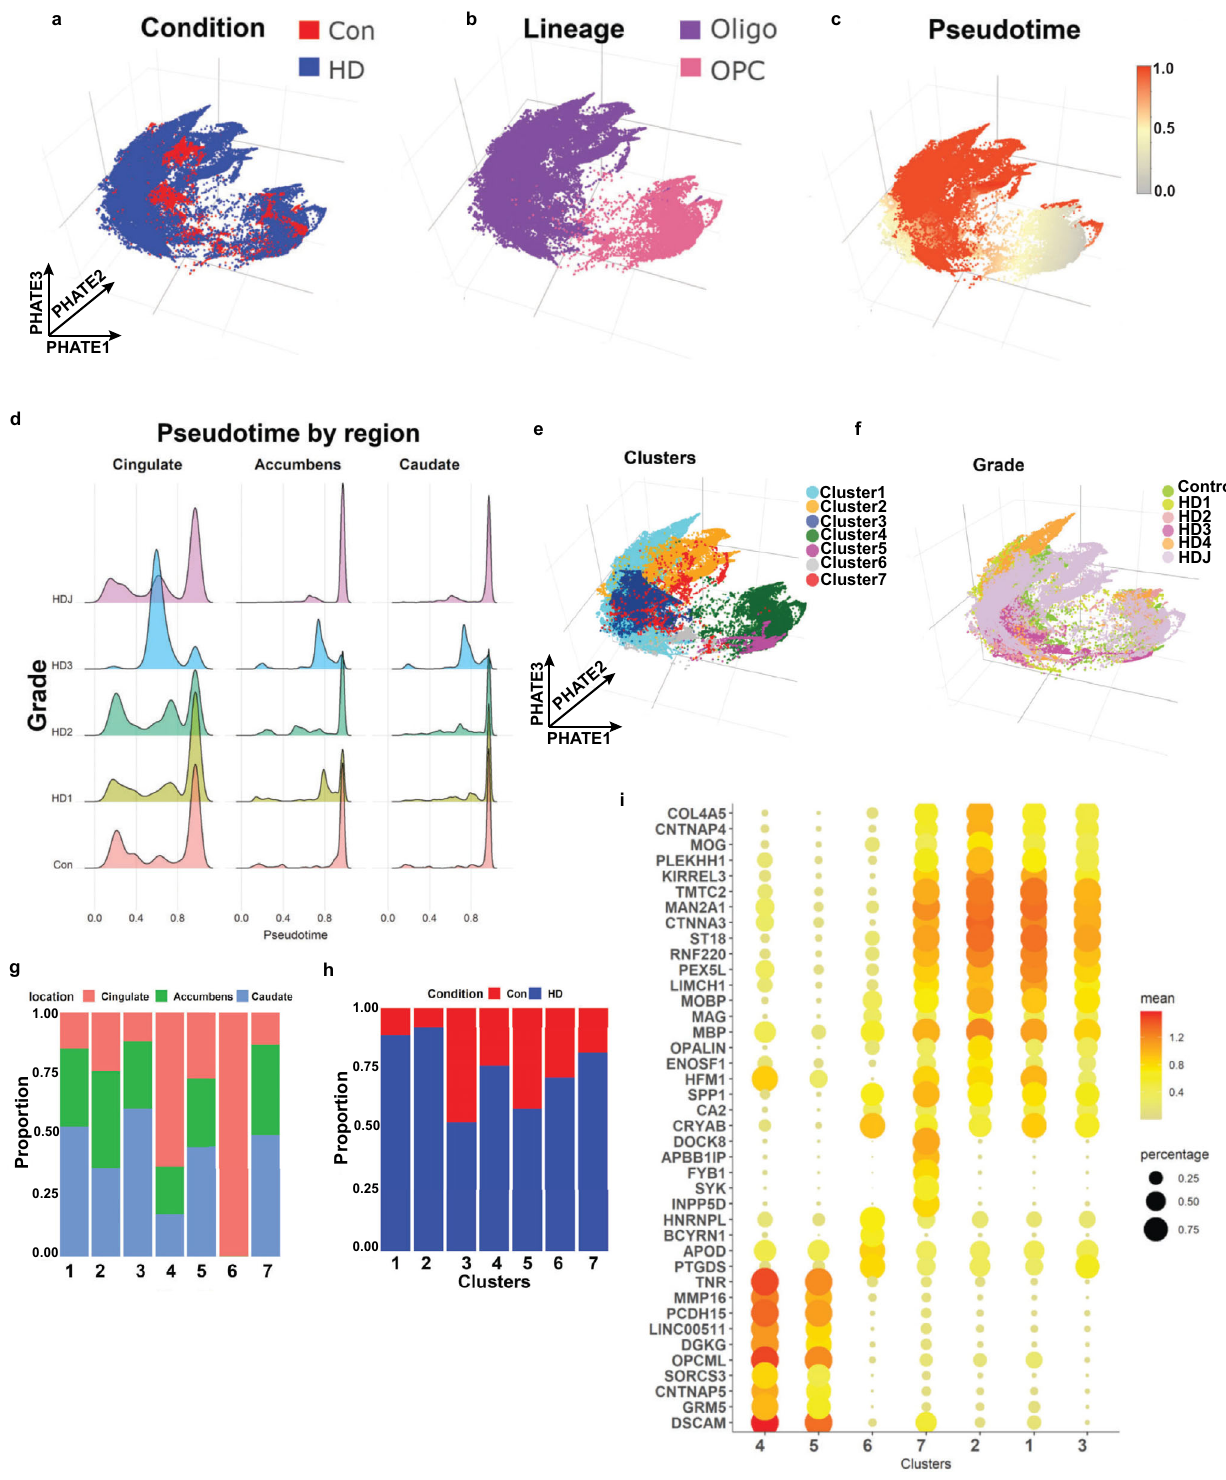
Fig. 5 | Huntington disease oligodendrocytes are less mature. Projection of control and HD nuclei in the PHATE dimension color-coded by condition ( a ), lineage ( b ), pseudotime value ( c ), cluster (using the Levine algorithm) ( e ), and HD grade( f ).NotethatOPCshavethelowestpseudotimevaluesin c ,asOPCswereset as root nodes, while OLs had high values. d Pseudotime values are shown in his- togramsacrossbrainregionandHDgrade.Notethattheproportionofnucleiwith